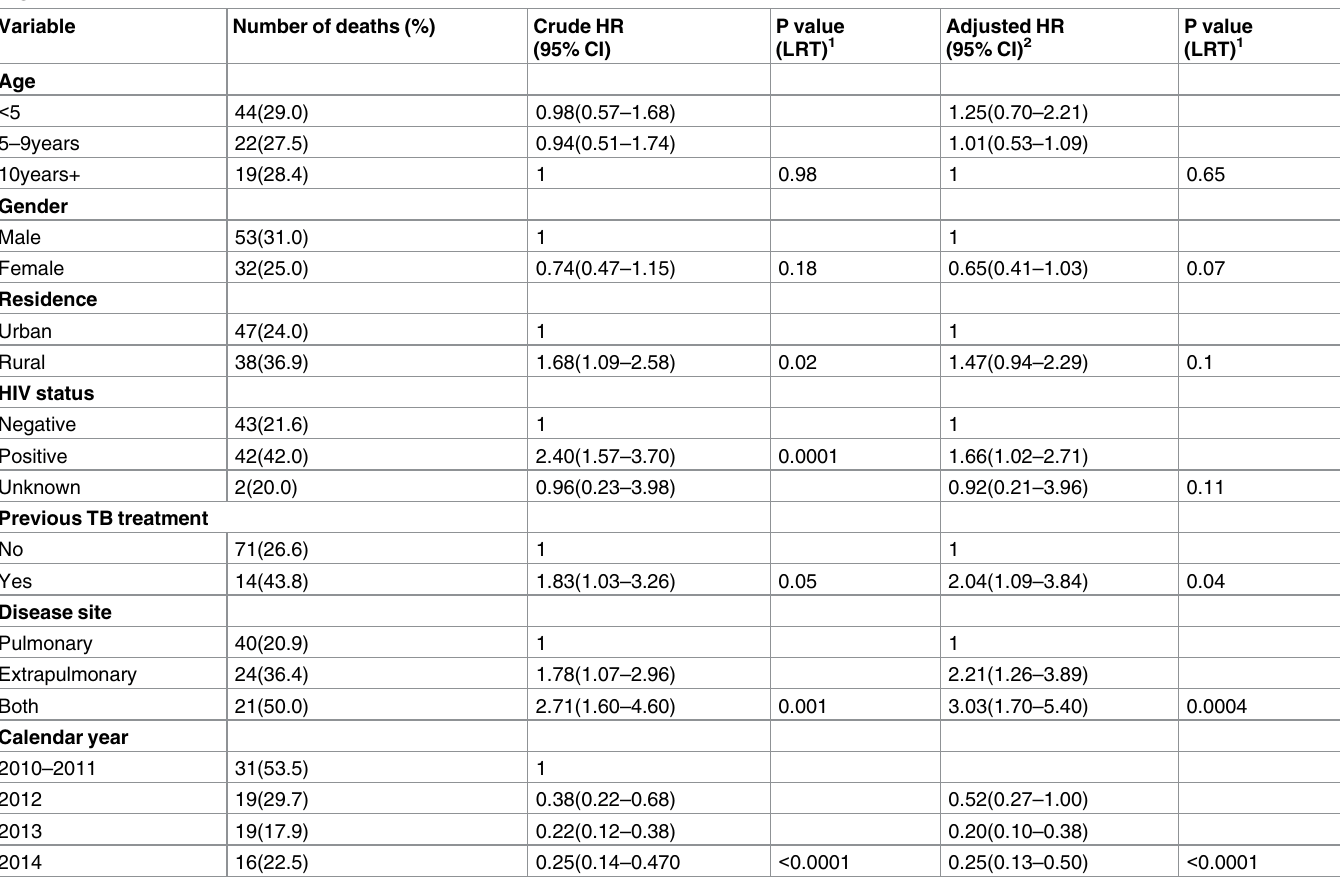
Table 3. Univariable and multivariable analysesof risk factors for mortality among children, TB clinic, Aminu Kano Teaching Hospital, Kano,